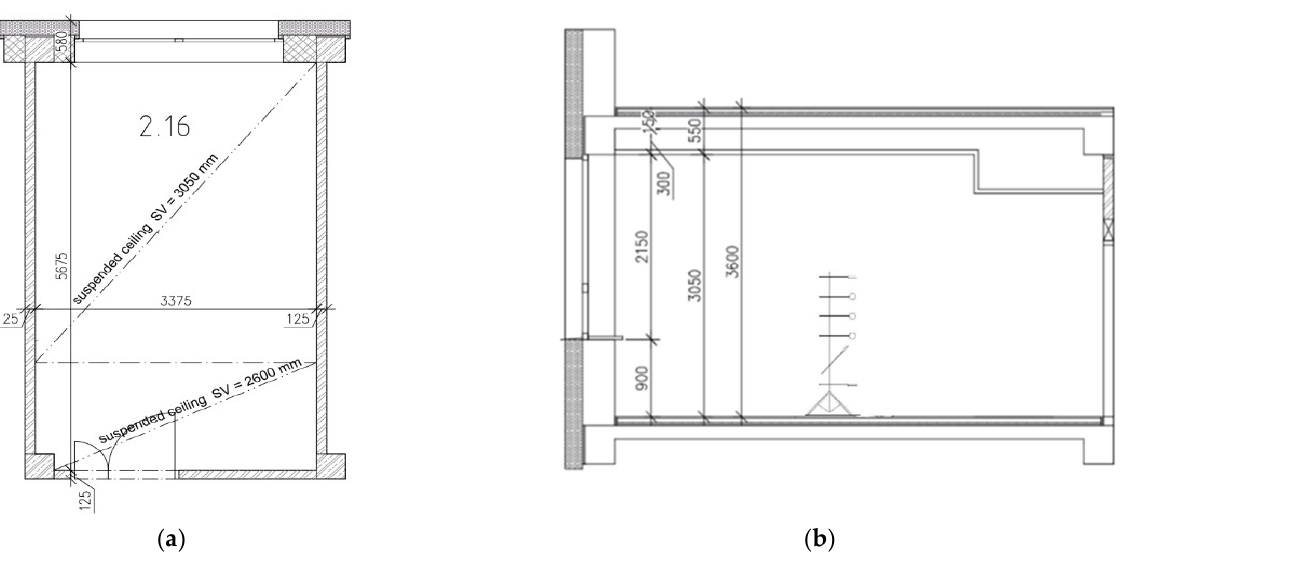
Figure 2. ( a ) Floor plan of the office, and ( b ) the section of the office.